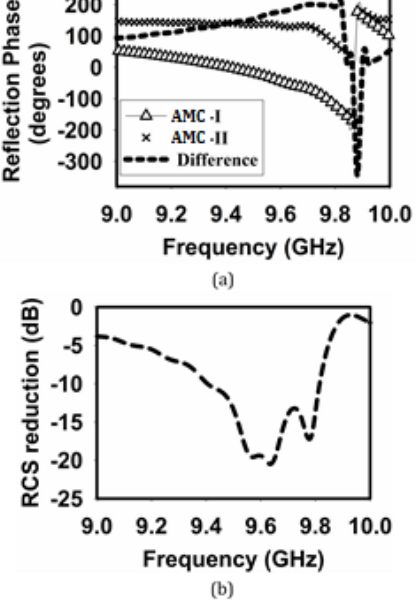
Figure.8. (a) Fabricated prototype of cavity antenna